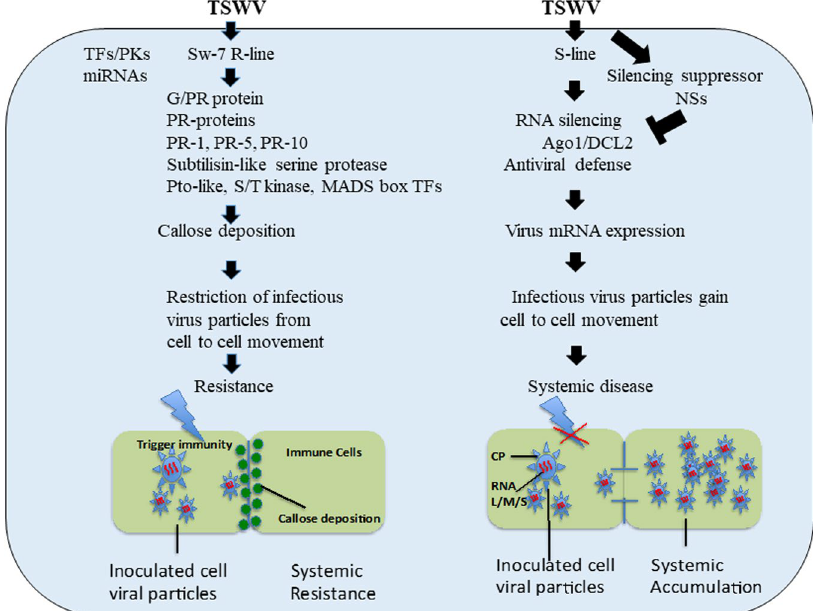
Figure 4. A schematic model illustrating the predicted mechanisms of virus resistance to TSWV in Sw-7 tomato plants or of symptom expression in the susceptible (S) plants. The Sw-7 resistance requires defense- related signaling molecules, including pathogenesis-related 1 (PR-1) protein, pathogenesis-related 5 (PR-5) (osmotic-like protein), glycine/proline rich protein (GRP), nodulin (PR-10), Pto-like R-gene (bacterial resistance), MADS box transcription factors (candidate Ty-2 gene), and subtilisin serine protease, all of which showed elevated expression in the Sw-7 line relative to S-line. The potential functional roles of the above stated genes, and signaling pathways including GRP-triggered PR proteins, are to actively communicate to neighboring cells, resulting in callose, lignin, and suberin deposition to the cell wall and leading to restricted cell-to-cell movement of TSWV. This in turn leads to the resistance phenotype in the Sw-7 plants. For the susceptible response in the S-line, we speculate that the virus-encoded molecular factors would suppress the host immune pathways, leading to TSWV replication, transcription and translation. Abundance of viral RNA accumulation in the cells would trigger the expression of RNA silencing pathway genes in the S-line, including Argonaute 1 (Ago1) and Dicer-like 2 (DCL 2), resulting in antiviral defense. In the meantime, TSWV-encoded silencing suppressor protein (NSs) would suppress (sequester) the host antiviral defense pathway, leading to over-accumulation of viral particles. This in turn results in the opening of the cell wall/plasmodesmata to virus cell-to-cell and systemic movement, producing the disease